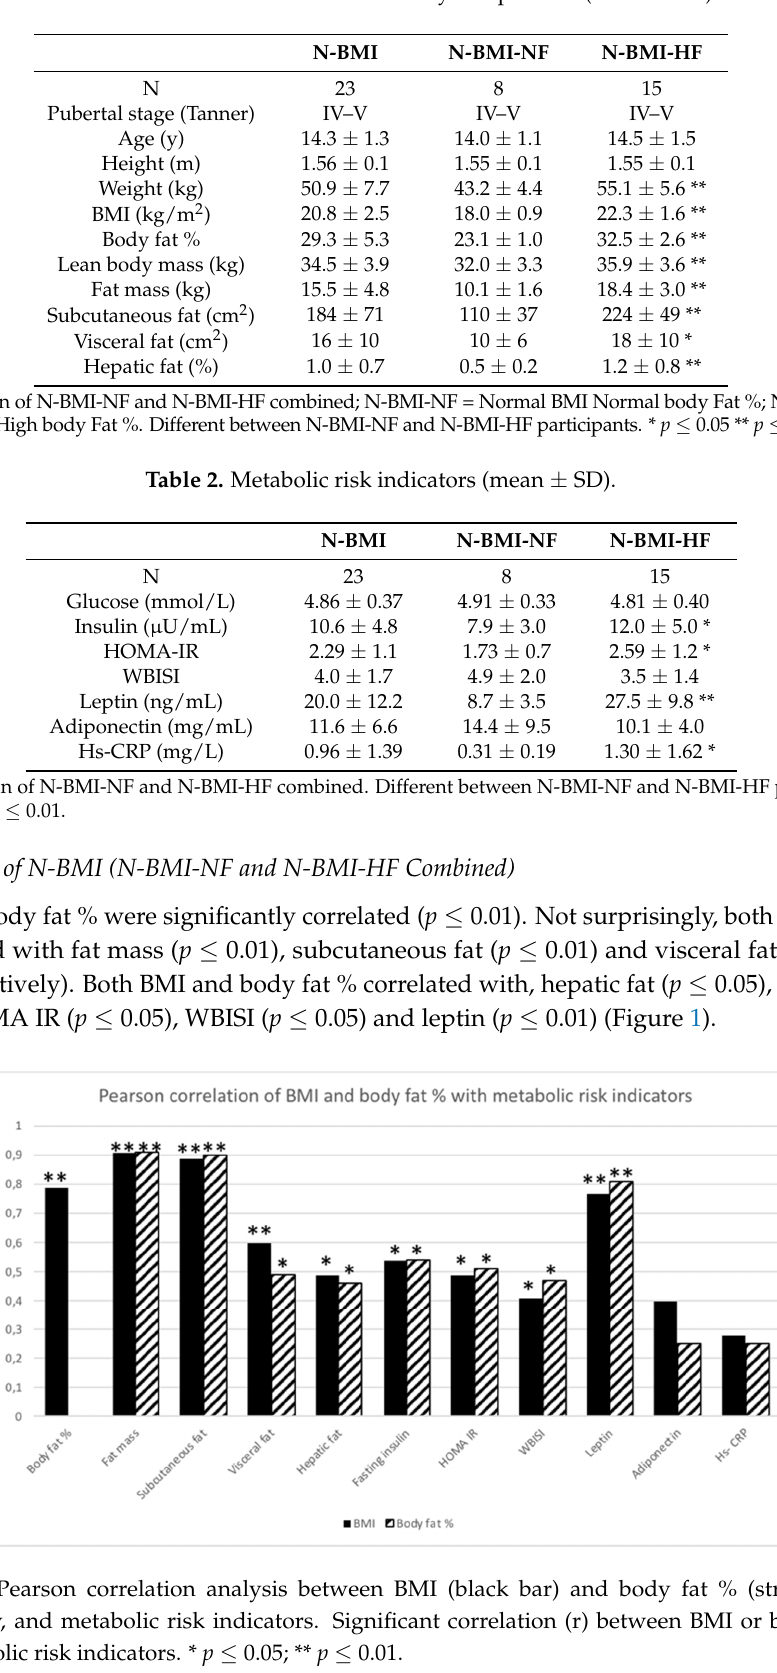
Figure 2. Pearson correlation analysis between homeostasis Model Assessment Insulin Resistance (HOMA-IR; black bar) and Whole Body Insulin Sensitivity Index (WBISI; striped bar) with metabolic risk indicators. Significant correlation (r) between HOMA-IR or WBISI with metabolic risk indicators. * p ≤ 0.05 ** p ≤ 0.01. 4. Discussion This study shows that a normal BMI in sedentary Hispanic adolescent girls is not an indicator of the absence of metabolic risk. In this group of subjects, a high body fat %, also in the presence of a normal BMI, is associated with metabolic risk factors and altered body composition. These girls present increased fat mass, abdominal fat deposits, insulin resistance and increased plasma concentrations of insulin and leptin. Moreover, low grade chronic whole body inflammation, measured by high Hs-CRP, was detected in adolescents with a high body fat %, as previously described in obese adolescents [15,16]. Collectively, these data indicate that these girls with a BMI